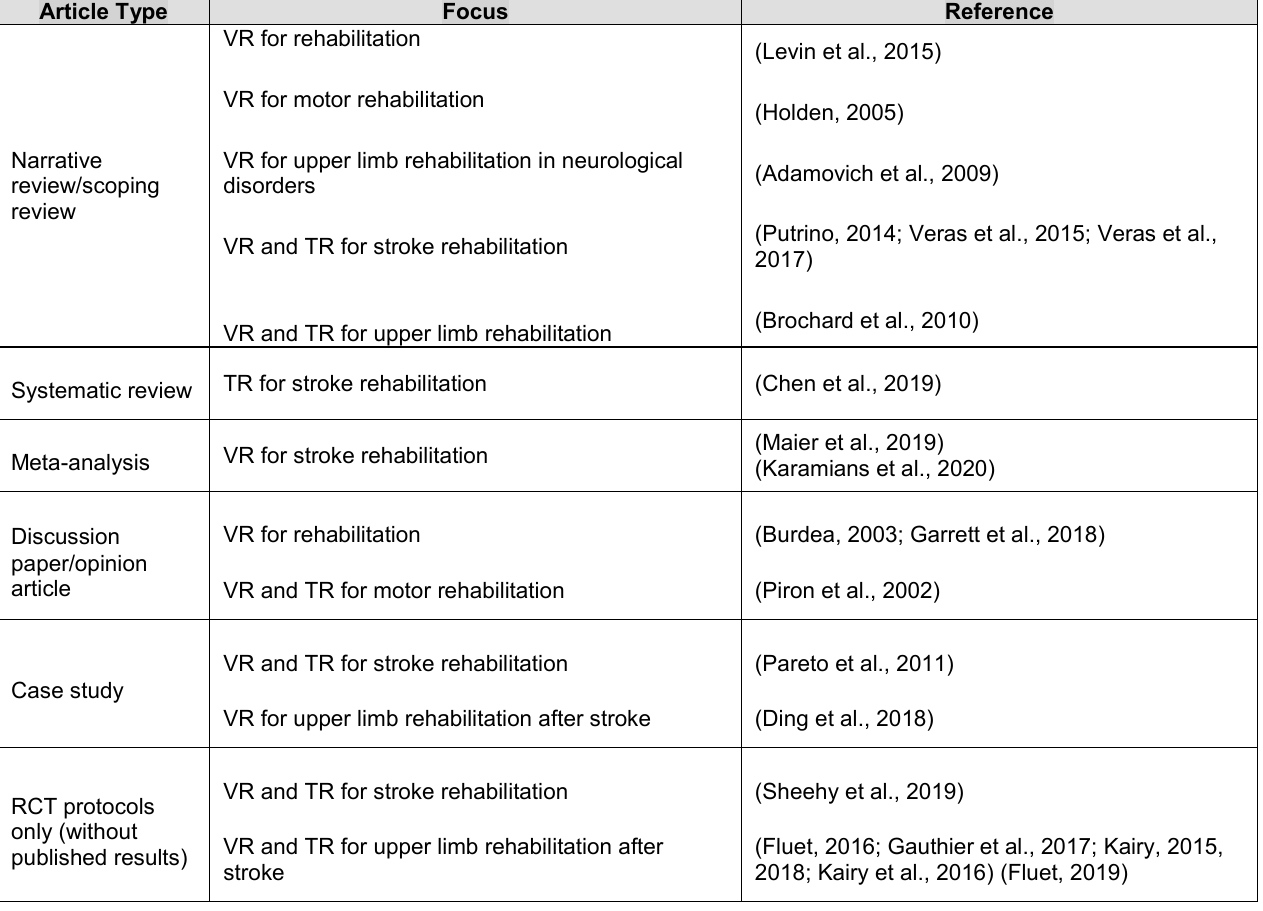
Description of Articles Initially Included by PRISMA